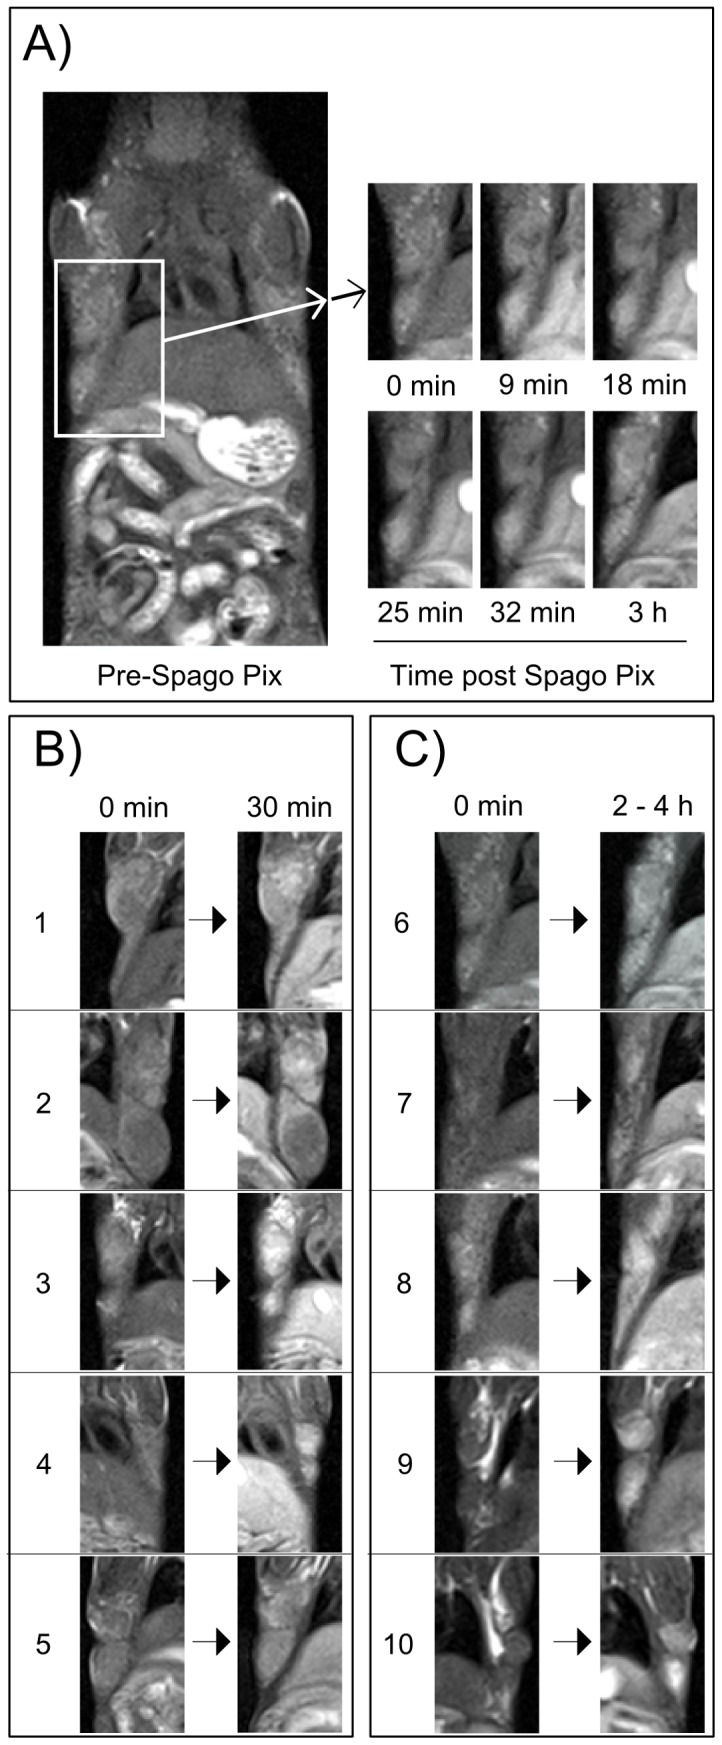

T
1-weighted MR images of the torso of a mouse where enlargements of the indicated tumor site are shown in Panel A before administration of Spago Pix and at five time points thereafter.Panels B and C show enlargements of ten tumor sites (labeled 1–10) in different animals before administration of Spago Pix and 30 min (B) and 2–4 h (C) thereafter.